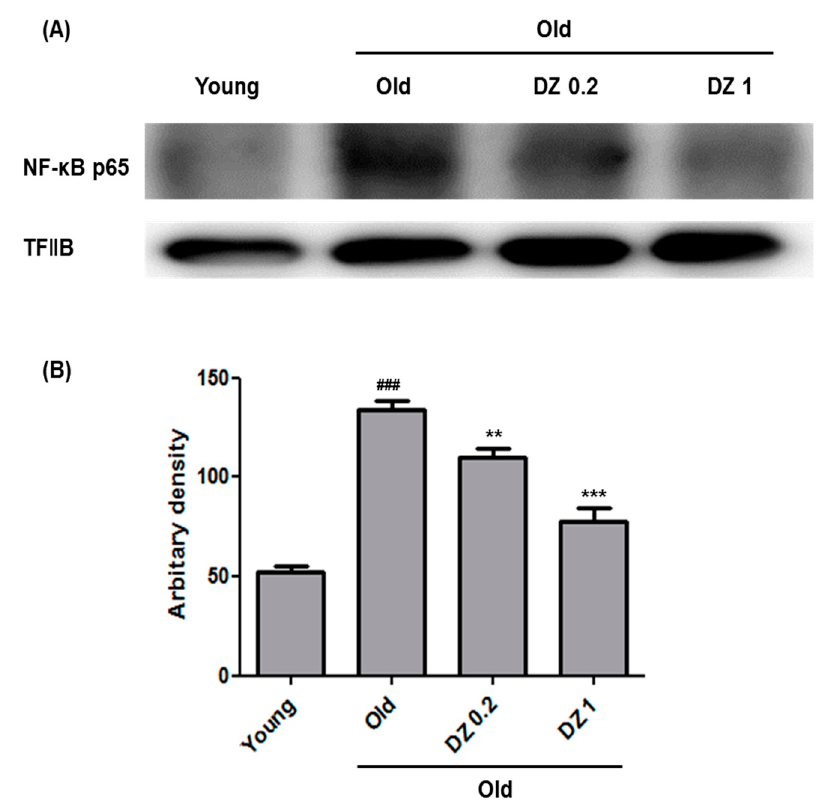
Figure 5. Inhibition of NF- κ B translocation in rat aorta by Dendranthema zawadskii (DZ) extract. ( A ) Western blot analysis was performed to detect NF- κ B p65 protein level in nuclear extract (30 µ g protein), aorta tissue from each group. Young, 5-month-old rats; Old, 15-month-old rats; DZ 0.2, 15-month-old rats treated with DZ extract (0.2 mg/kg/day) for 1 week; DZ 1, 15-month-old rats treated with DZ extract (1 mg/kg/day) for 1 week. ( B ) Density analysis of NF- κ B p65. Statistical significance: ### < 0.001 compared to young. ** < 0.01 compared to old, *** < 0.001 compared to old, respectively.